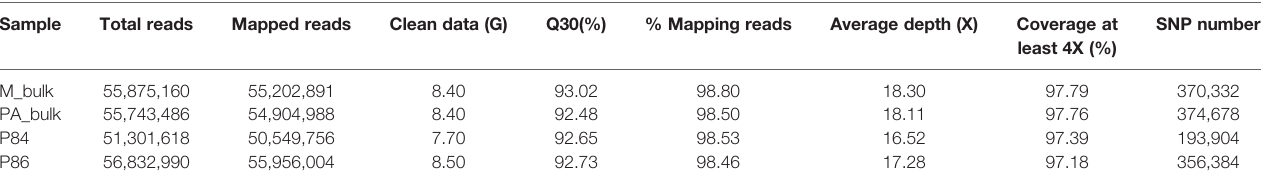
TABLE 3 | Summary of sequencing data and alignment result of BSA-Seq. Sample